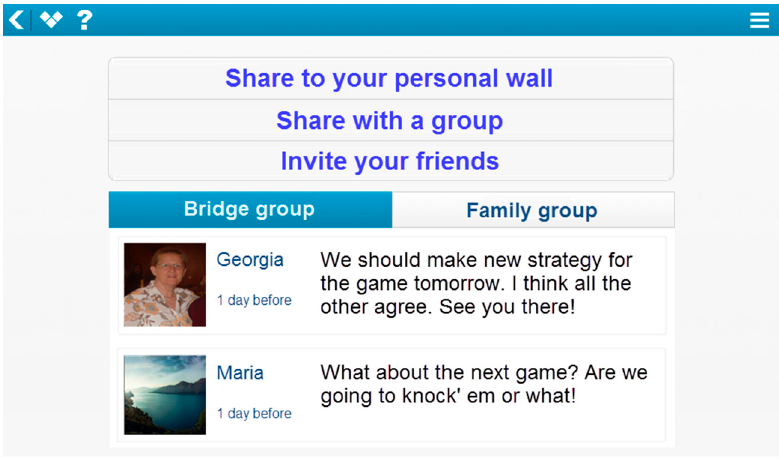
Figure 5. Social network access from Senior App Suite.